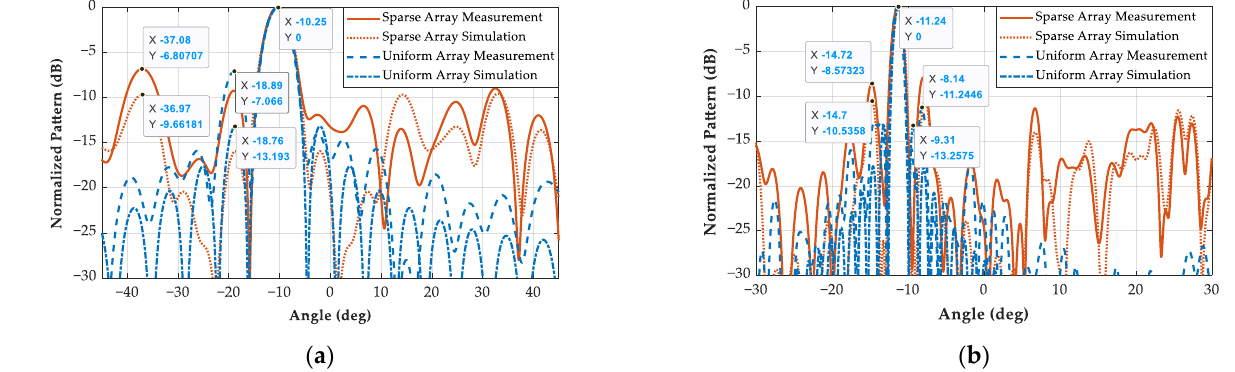
Figure 14. The sidelobe suppression performance of the optimized array compared with the uniform half-wavelength array: ( a ) SRS detection type; ( b ) MRS detection type.